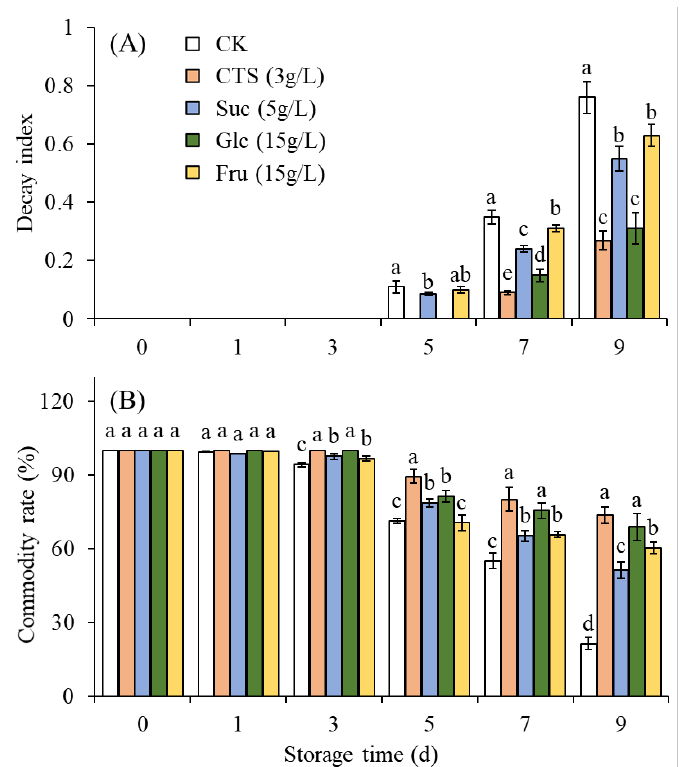
Figure 4. Effects of chitosan (3 g/L), sucrose (5 g/L), glucose (15 g/L), and fructose (15 g/L) on the ( A ) decay index and ( B ) commodity rate of strawberry fruits stored at 15 ± 2 °C for 9 d. CK represents that strawberry fruits were immersed with water before storage. Data are mean of three replicates. Different letters on top of bars in the same storage time indicate a significant difference (Tukey’s HSD test, p < 0.05). CTS, chitosan; Suc, sucrose; Glc, glucose; Fru, fructose.